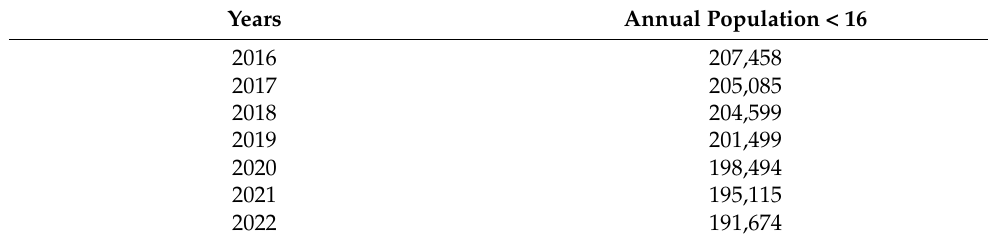
Table 2. Annual population in Kobe City under the age of 16.